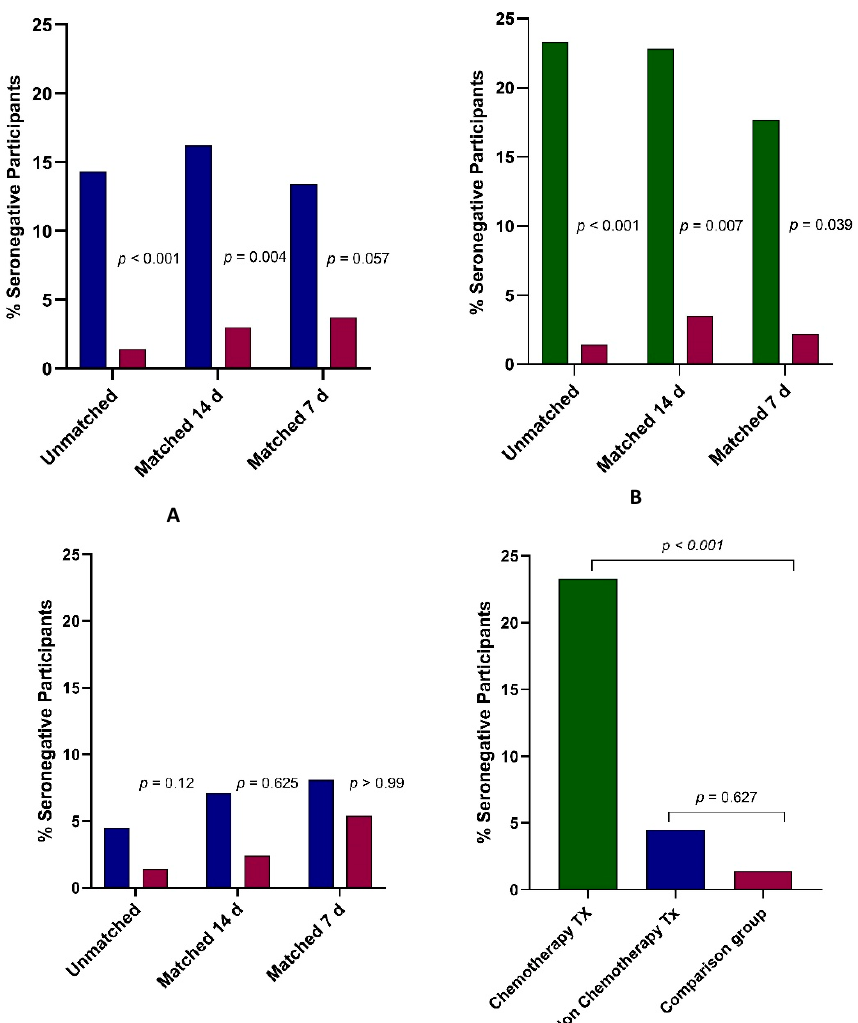
Figure 1. Vaccine response: ( A ) percent of seronegative patients with cancer (blue bars) and non-cancer participants (maroon bars) in unmatched analysis (cancer patients, n = 140; controls, n = 215, p < 0.001) and matched analyses (±14 days following second vaccine dose, n = 99 pairs, p = 0.004; and ±7 days following second vaccine dose, n = 82 pairs, p = 0.057); ( B ) percent of seronegative cancer patients undergoing chemotherapy at the time of vaccination (green bars) compared to non-cancer participants (maroon bars) in unmatched analysis (cancer patients, n = 73; controls, n = 215, p < 0.001) and matched analyses (±14 days, n = 57 pairs, p = 0.007; and ±7 days, n = 45 pairs, p = 0.039); ( C ) percent of seronegative cancer patients undergoing non-chemotherapy treatment at the time of vaccination (blue bars) compared to controls (maroon bars) in unmatched analysis (cancer patients, n = 67; controls, n = 215) and matched analyses (±14 days, n = 42 pairs; and ±7 days, n = 37 pairs). In all analyses, the differences were not significant (NS); ( D ) in the unmatched analysis, percent of seronegative participants in the subgroups of patients undergoing chemotherapy treatment (Tx) ( n = 73), non-chemotherapy treatment ( n = 67), and comparison group ( n = 215).